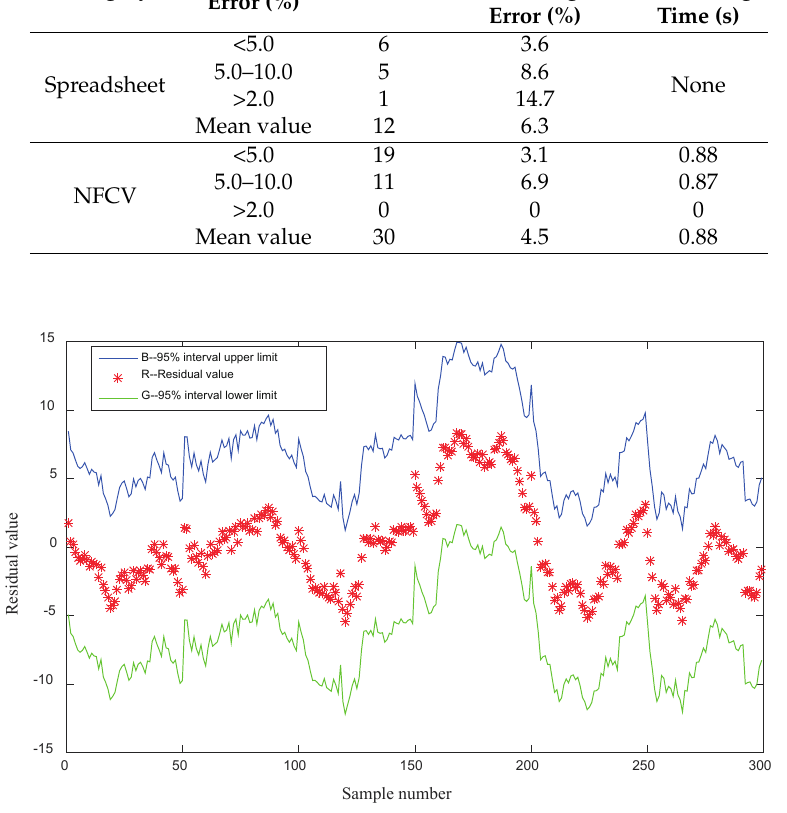
Figure 10. Residual graph of the multiple regression